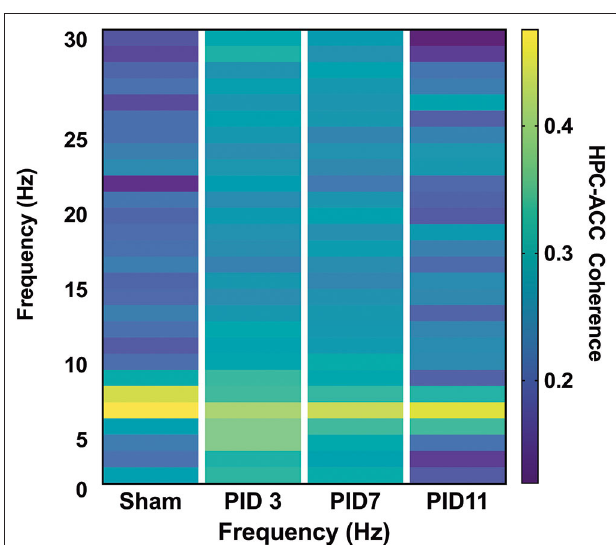
FIGURE 6 | HPC-ACC Phase Coherence. Dashed lines represent the theta band (6–10Hz). Adapted from Paxinos et al.